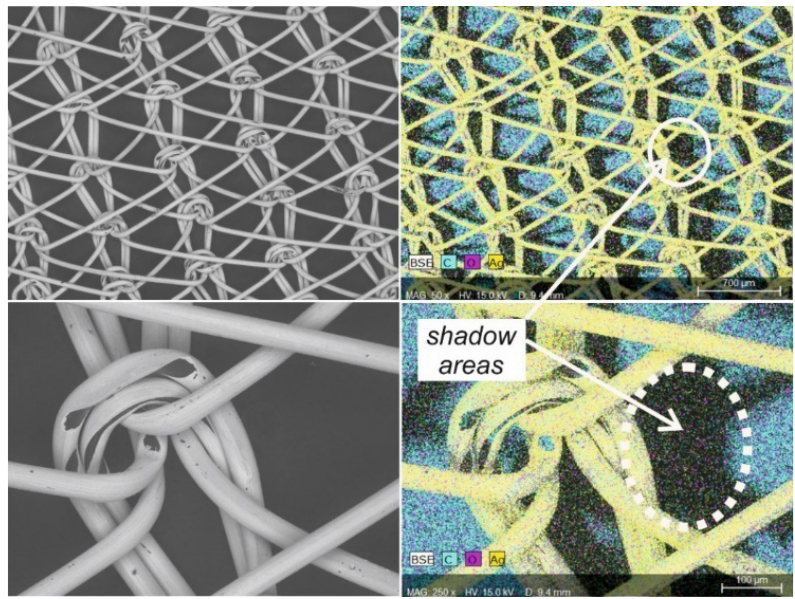
Figure 4. SEM images and related EDS images from a silver-coated yarn. Example for shadowing during EDS measurements.